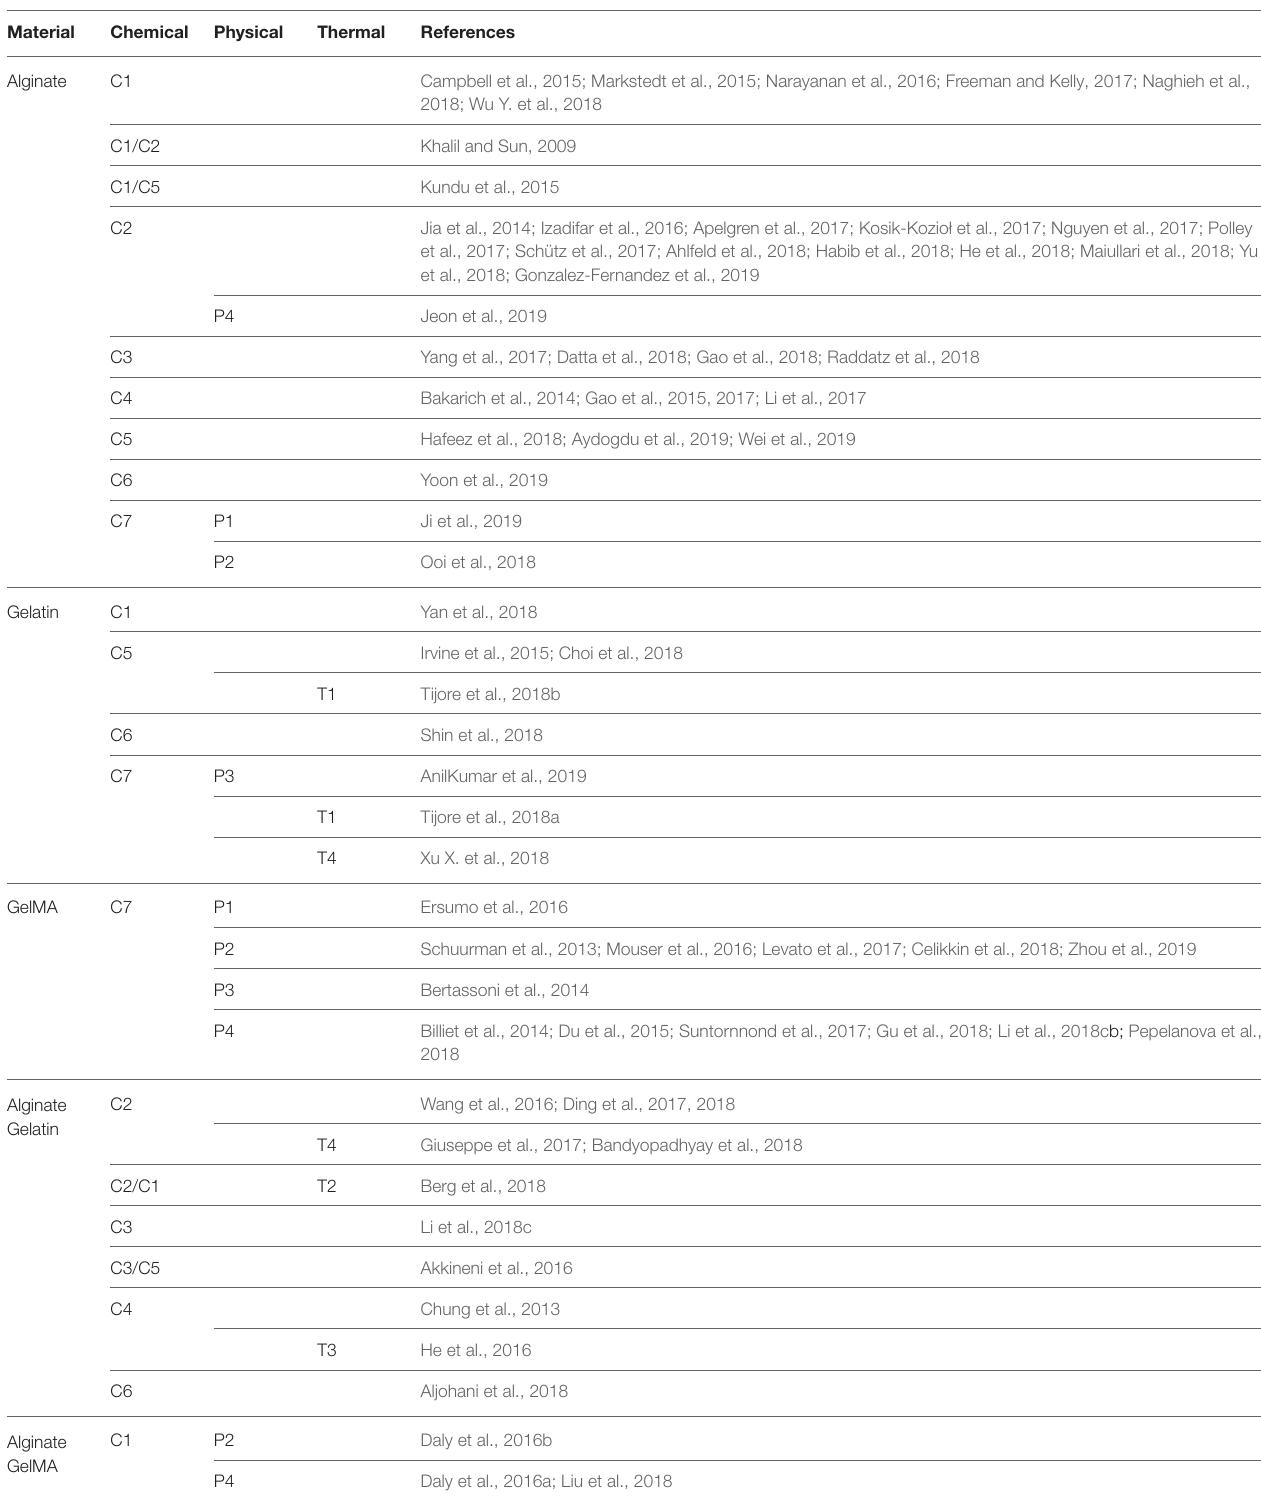
TABLE 3 | The three most used materials (alginate, gelatin, GelMA, and its combinations in pairs) with its different cross-linking methods. Material Chemical Physical